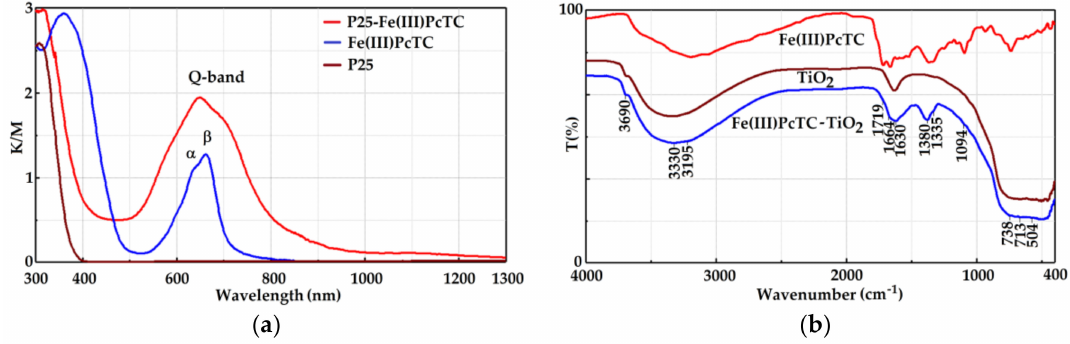
Figure 1. ( a ) Kubelka-Munk transformed reflectance spectra and ( b ) diffuse reflectance Fourier-transform infrared (DRIFT) spectra of P25-Fe(III)PcTC.